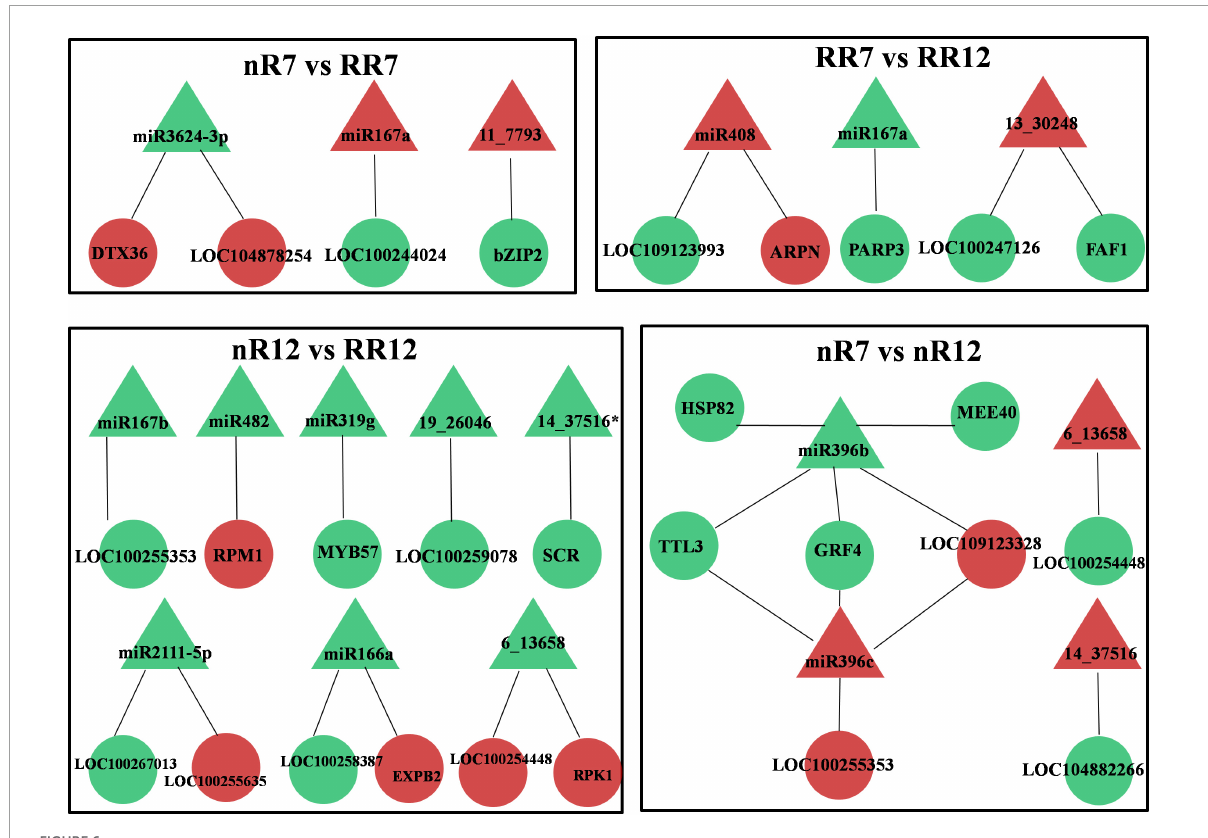
FIGURE6 Conjoint analysis of differentially expressed miRNAs and differentially expressed target genes in different groups, including nR7 vs. nR12, RR7 vs. RR12, nR7 vs. RR7, and nR12 vs. RR12. Red indicates up-regulated expression, while green indicates down-regulated expression. nR7, RR7, nR12, and RR12 represent the 70 DAP and 125 DAP sampling time points under nR and RR cultivation. Circles represented DEGs and triangles represented